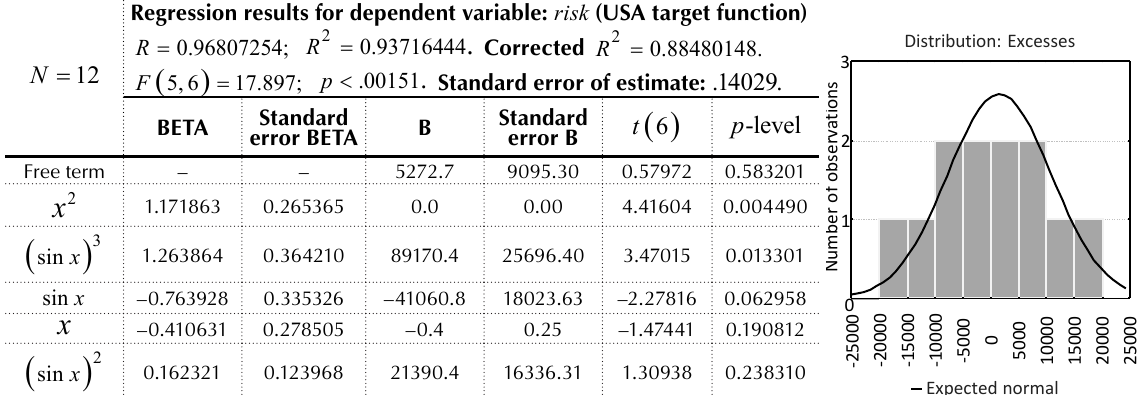
Table 2a. The results of regression of the standard deviation of the size of the Securities Investor Protection Corporation (SIPC) ( ) y from its volume ( ) x Regression results for dependent variable: risk (USA target function) 12 N =